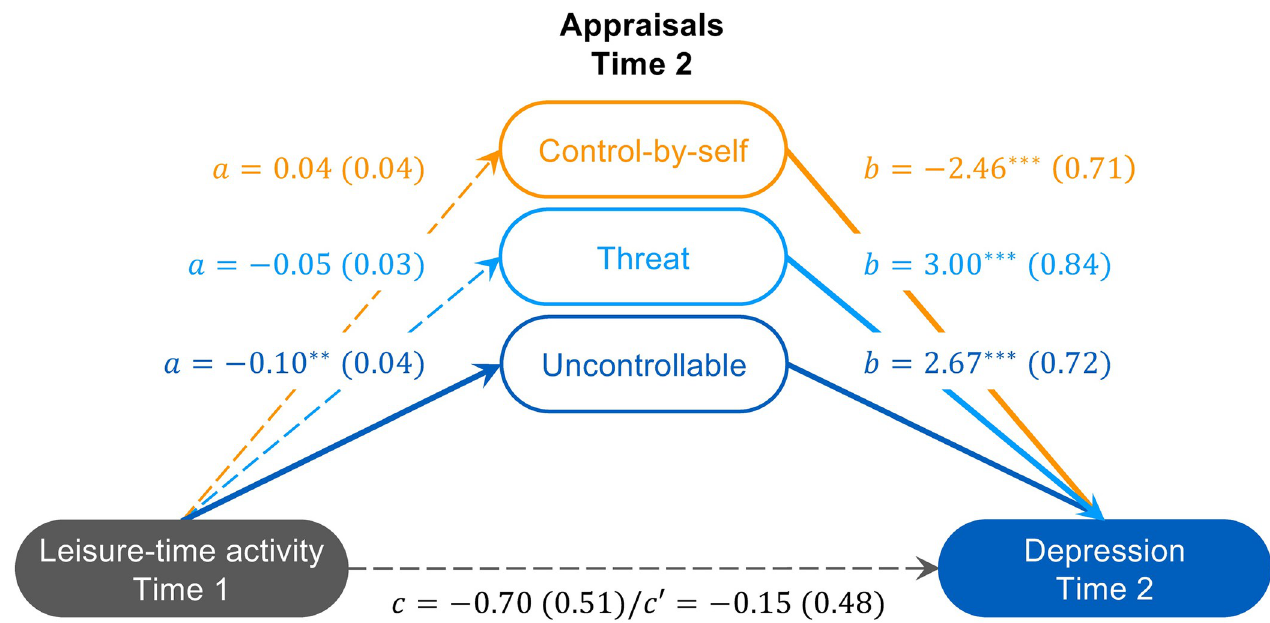
Fig 3. Uncontrollability linked leisure-time physical activity with subsequent feelings of depression. Model (unstandardized coefficients ( se )) of the relationship between leisure-time physical activity at Time 1 and feelings of depression at Time 2 as mediated through appraisals of threat, control-by-self, and uncontrollable at Time 2. Covariates were appraisals of threat, control by self, and uncontrollable at Time 1. Total effect pathway ( c ), direct effect pathway ( c ’), indirect effect pathway ( a , b ). �� p < 0.01; ��� p < 0.001.